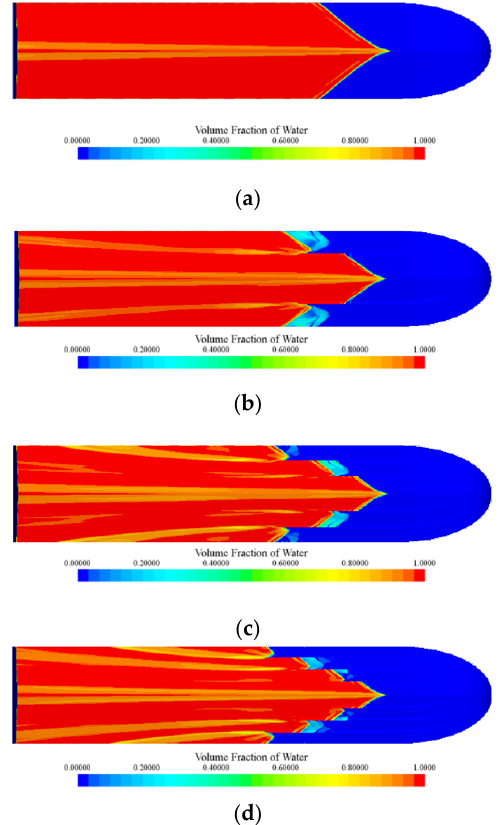
Figure 9. Volume fraction at Fr 1.78 for ( a ) bare hull; ( b ) 1 strip; ( c ) 2 strips; ( d ) 3 strips.